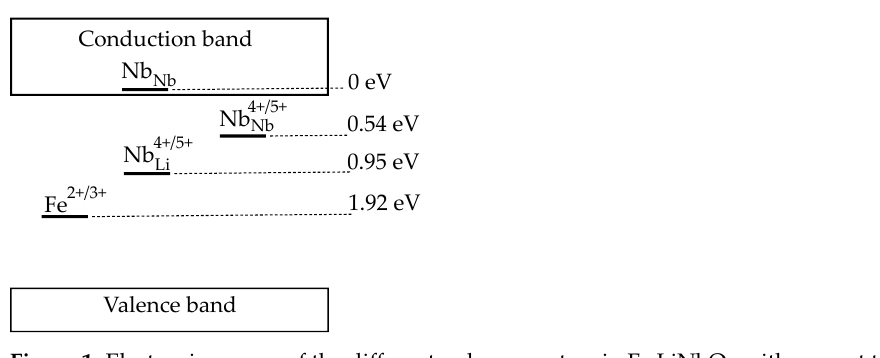
Figure 1. Electronic energy of the different polaron centers in Fe:LiNbO 3 with respect to the Nb Nb level in a rigid lattice (i.e., not considering the lowering in energy due to the local lattice distortion associated to the polaronic